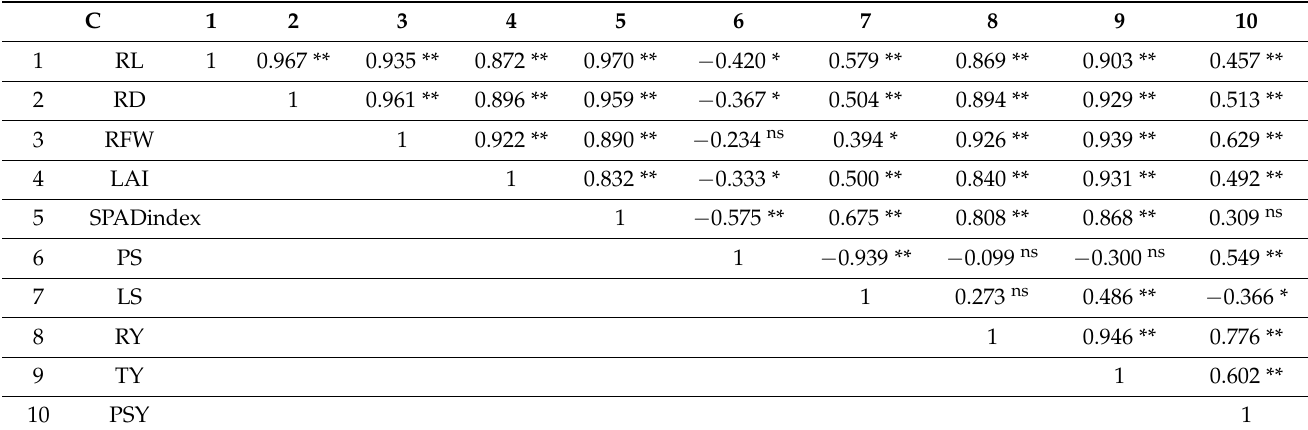
Table 9. A matrix of linear correlation coefficients and their significance levels between pure sugar yield (t ha − 1 ) and other important attributes under saline soil (EC e = 8.60 dS m − 1 ) conditions (data pooled over both seasons).